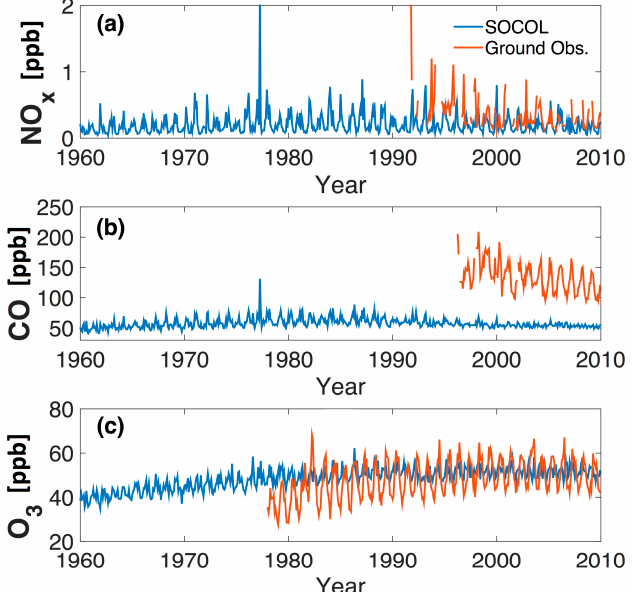
Figure 6. Time series (monthly mean values) of ( a ) NO x ; ( b ) CO; and ( c ) ozone for SOCOL (from 700 hPa level, blue) and observations (red). The NO x and CO observations are from Jungfraujoch (Switzerland), while the ozone time series is an average from Zugspitze (Germany), Jungfraujoch (Switzerland), and Sonnblick (Austria) (see text for